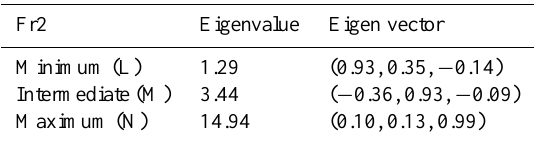
Table 2. Results from MVA applied to C1 magnetic field between